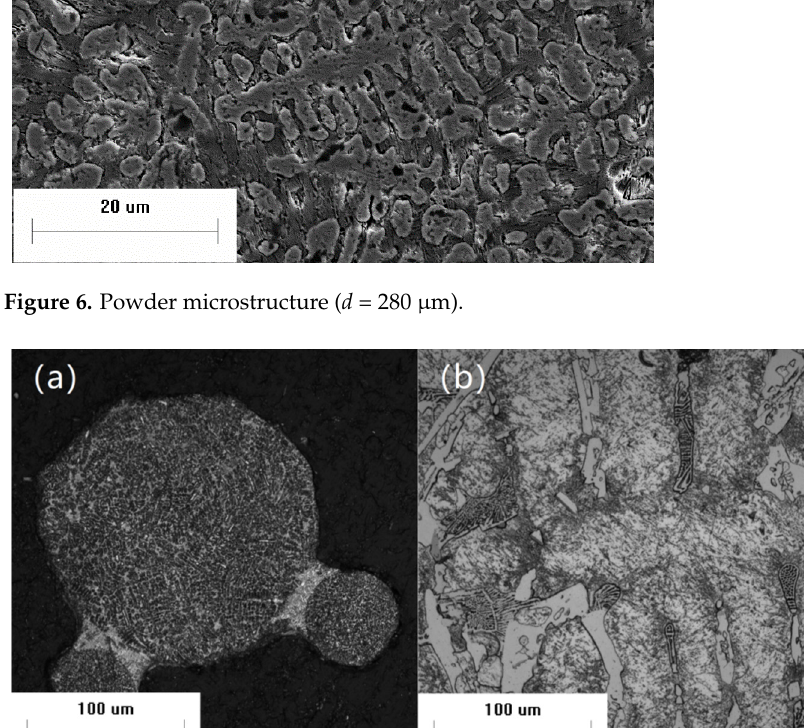
Figure 6. Powder microstructure ( d = 280 μ m).